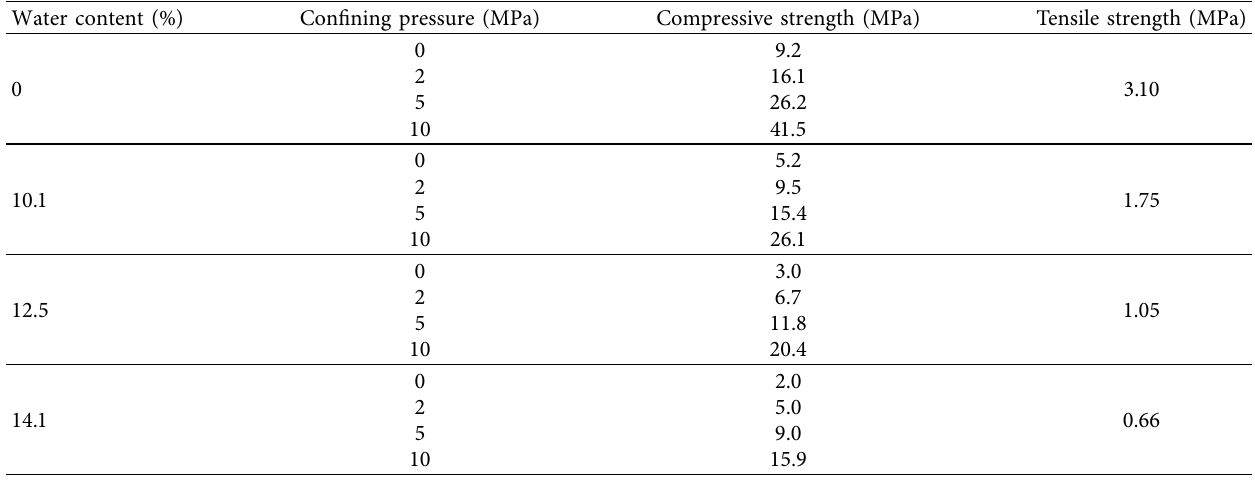
Table 1: Summary of mudstone strength test results.